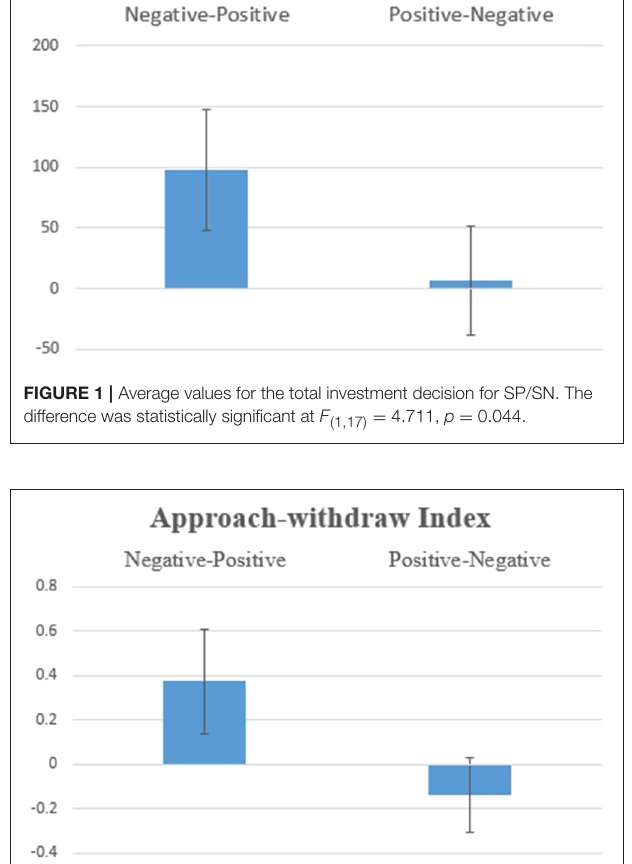
FIGURE 2 | Average values for the Approach Withdraw Index for SP/SN: two pieces of information were presented in Negative-Positive vs. Positive-Negative order: differences were statistically significant at F (1,17) = 7.486, p = 0.014.